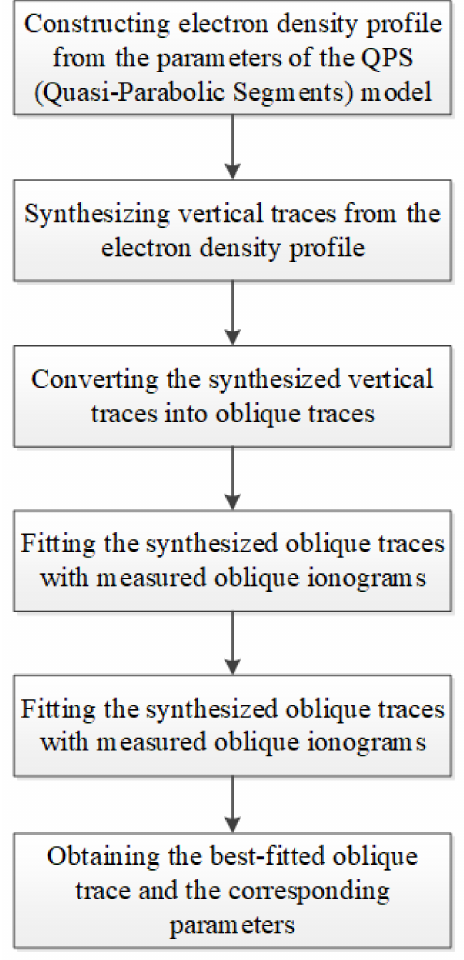
Figure 1. Flowchart of the automatic inversion of oblique